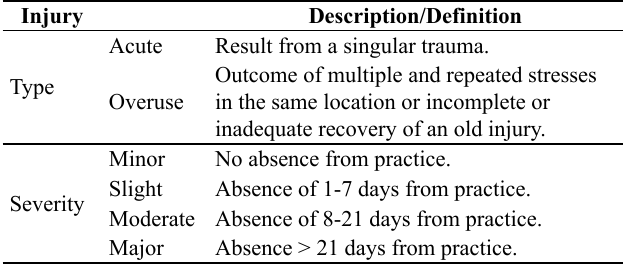
Table 1. Adopted injury definitions and classifications regarding